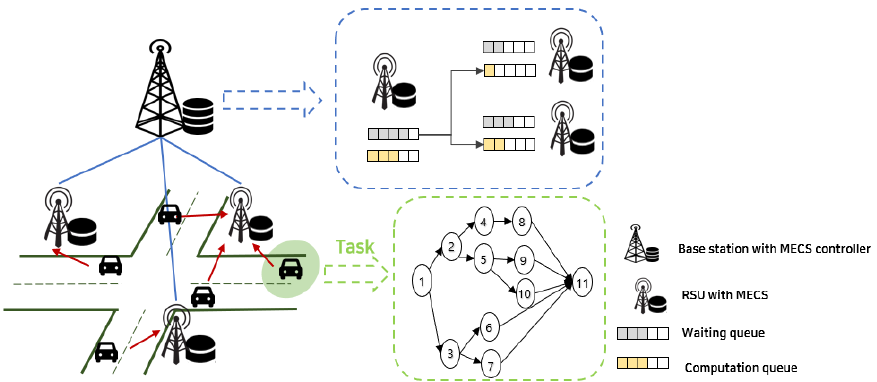
Figure 1. The architecture of the proposed MEC system.